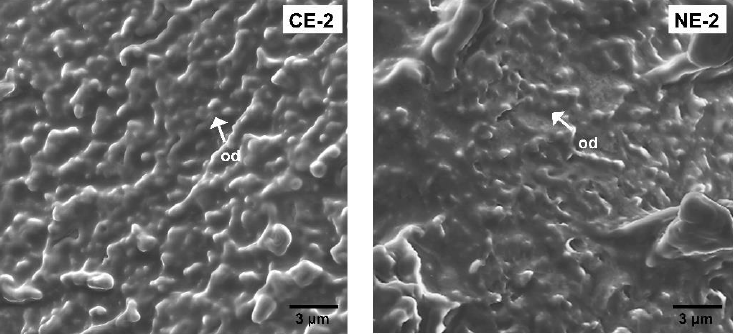
Figure 6. SEM images of conventional emulsions (CE) and nanoemulsions (NE) stabilised with lecithin (5%) and HPMC (2%). 500 × . od: oil droplets.